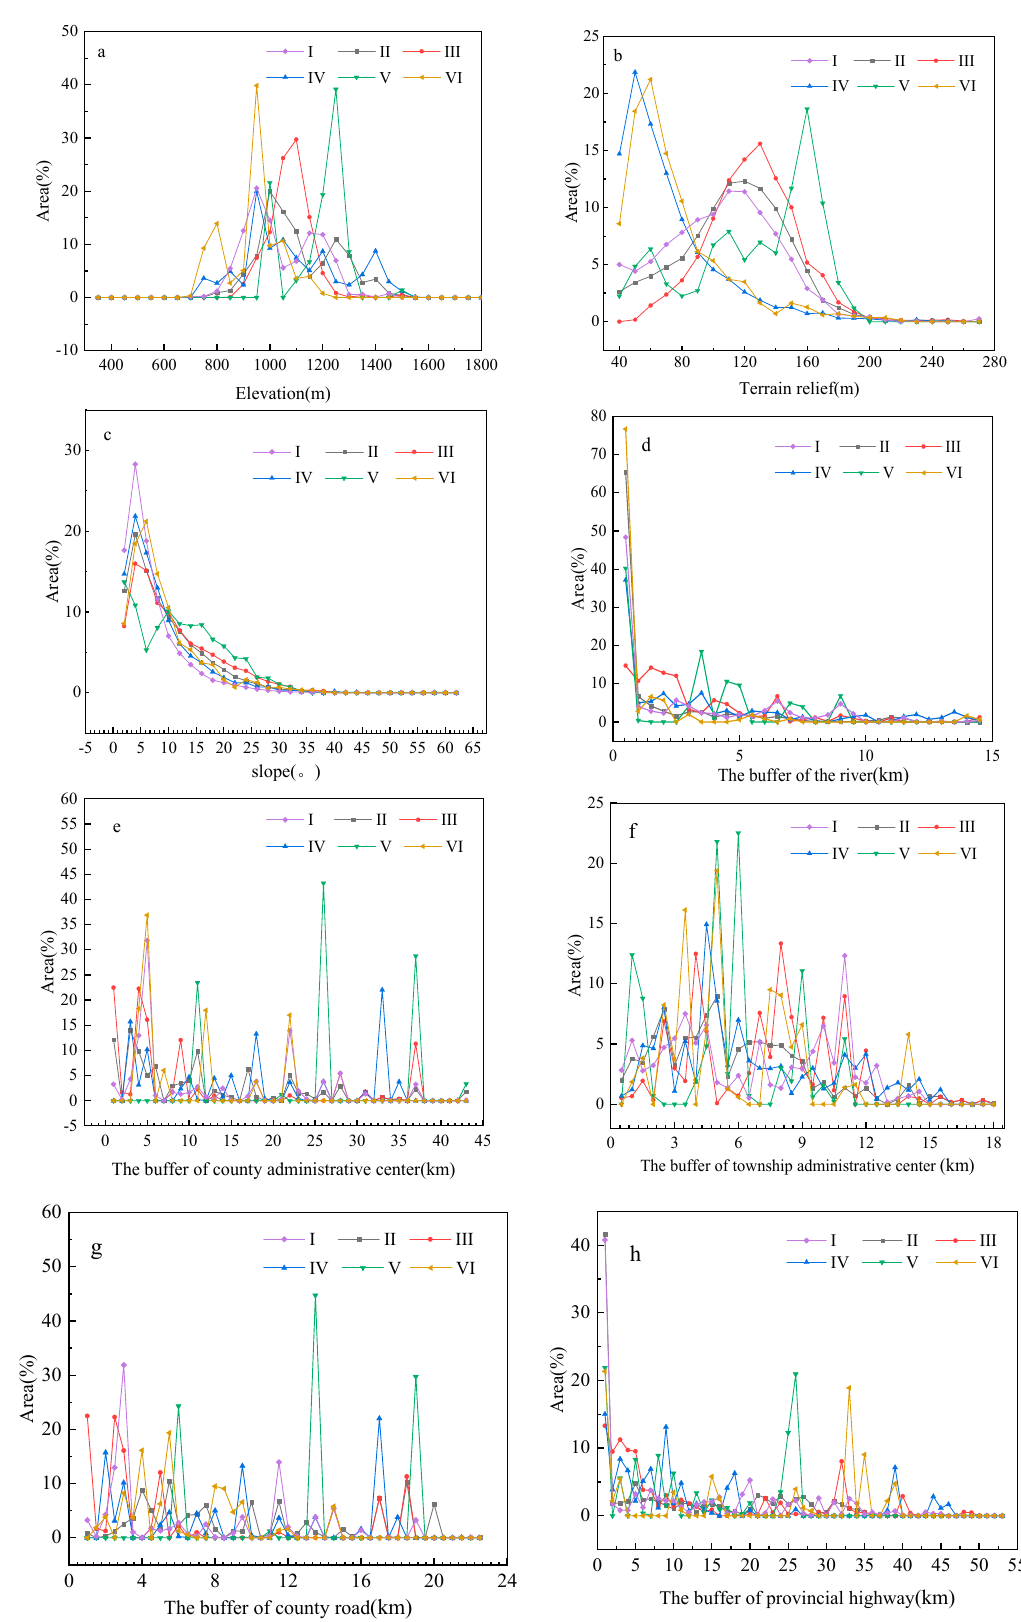
Figure 6. Spatial variation of gully farmland in Yan’an City. Note: Fruit forest zones (I); Greenhouse vegetables (II); Pond farming (III); Grain planting (IV); mulberry leaves (V); tobacco (VI).